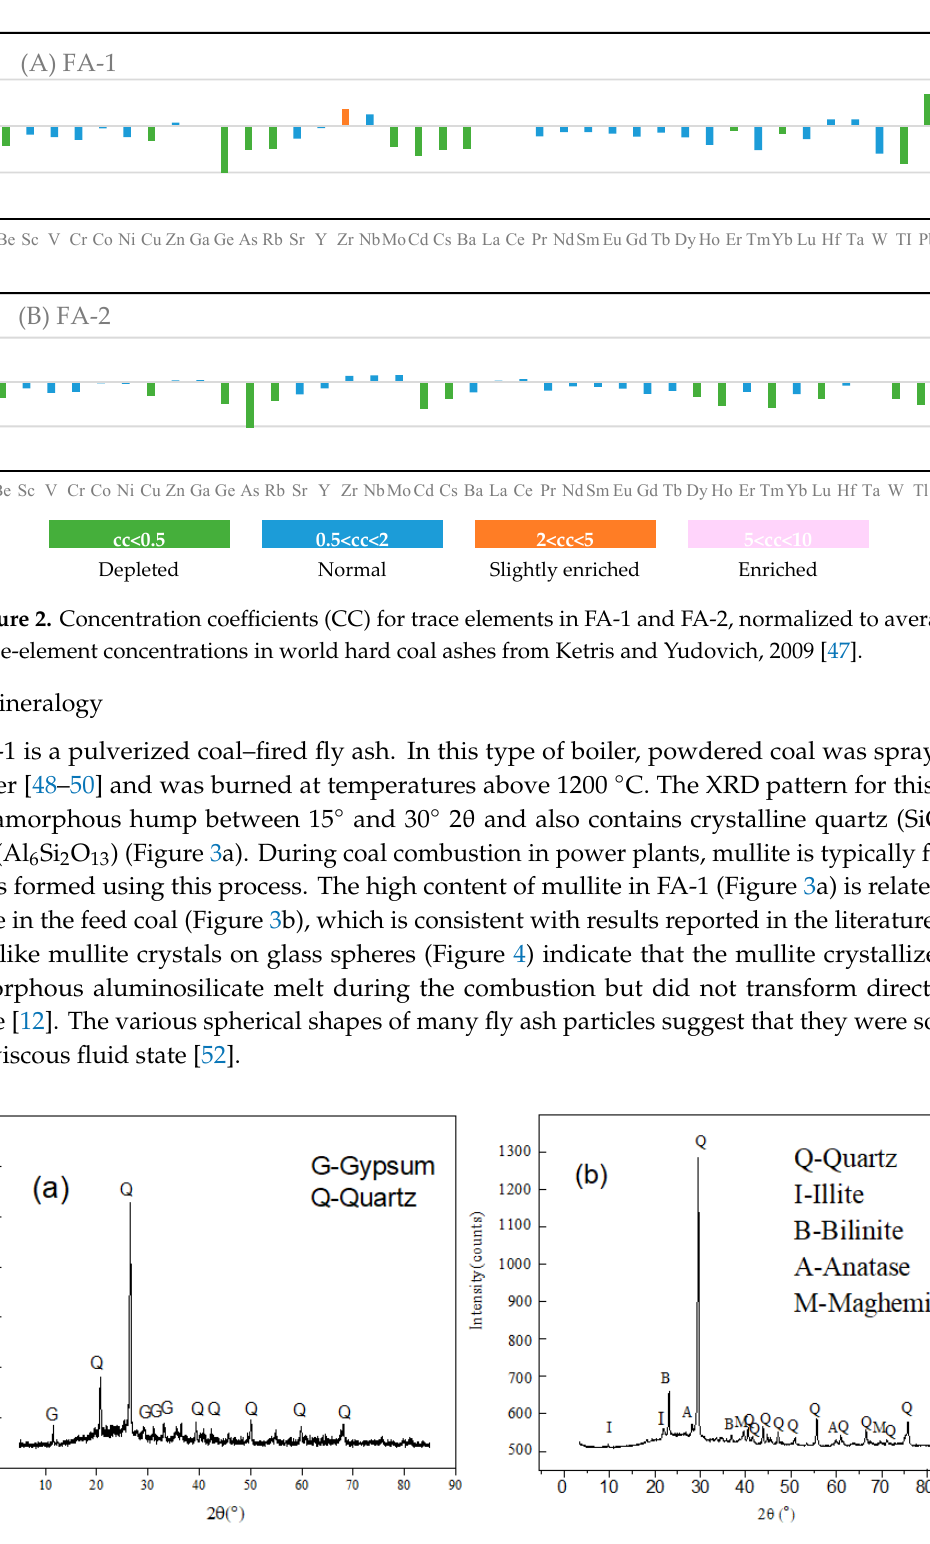
Figure 3. X-ray di ff raction (XRD) patterns for FA-1( a ) and the feed coal for FA-1( b Figure 2. Figure 5 Equivalent circuit: ( a ) real impedance of UWB antenna; ( b ) comparison of reflection coe ffi cients.